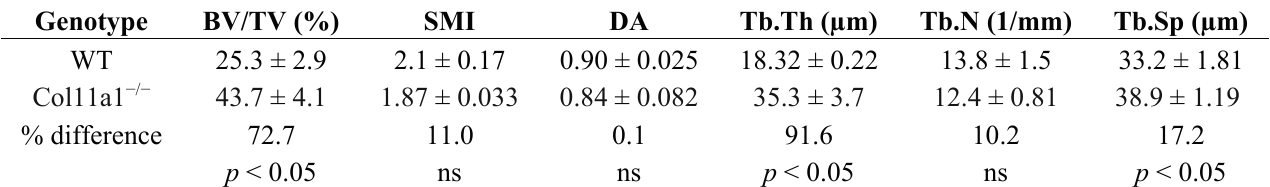
ns ns p < 0.05 ns p <